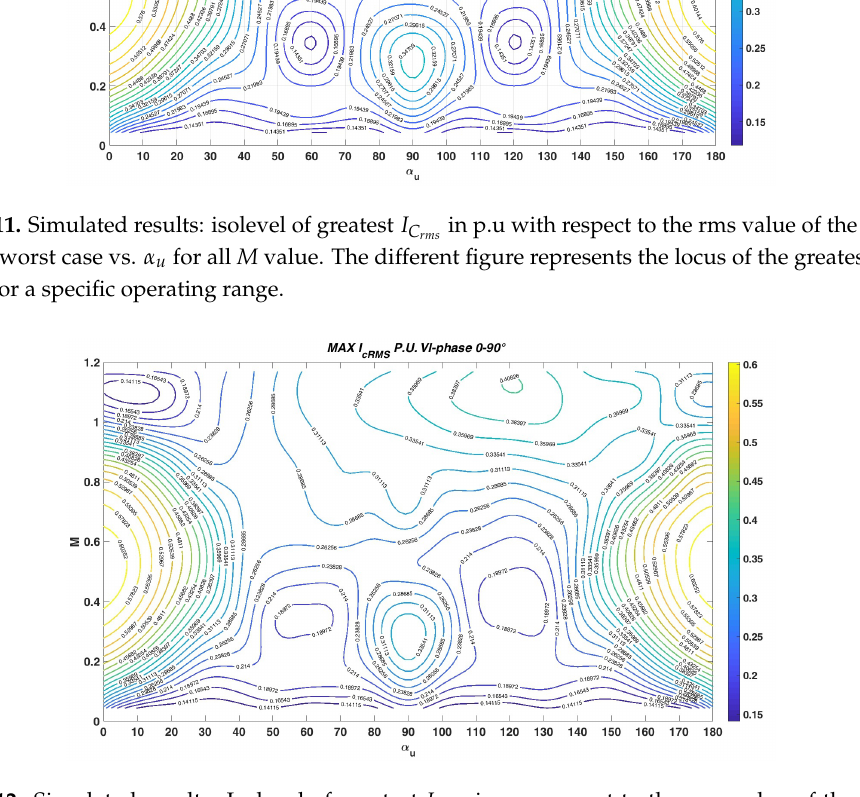
in p.u respect to the rms value of the phase rms